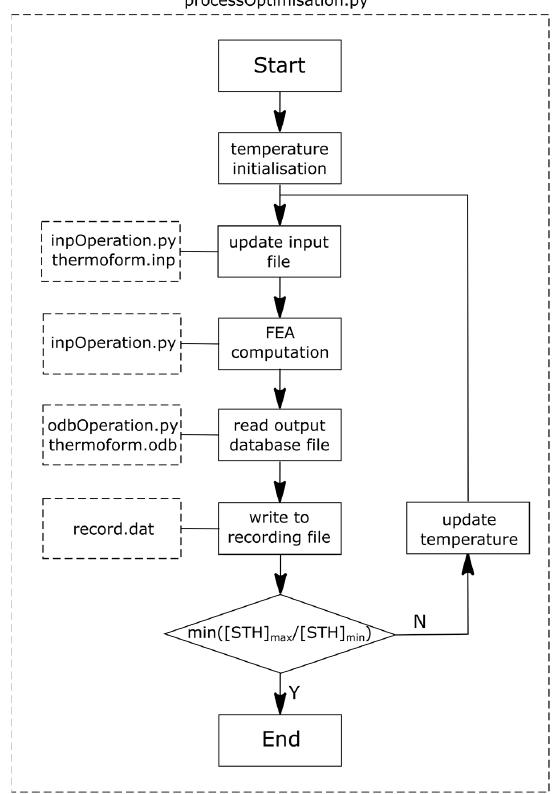
Figure 3. Optimisation flowchart.